Question: Which visualization type does this figure use?
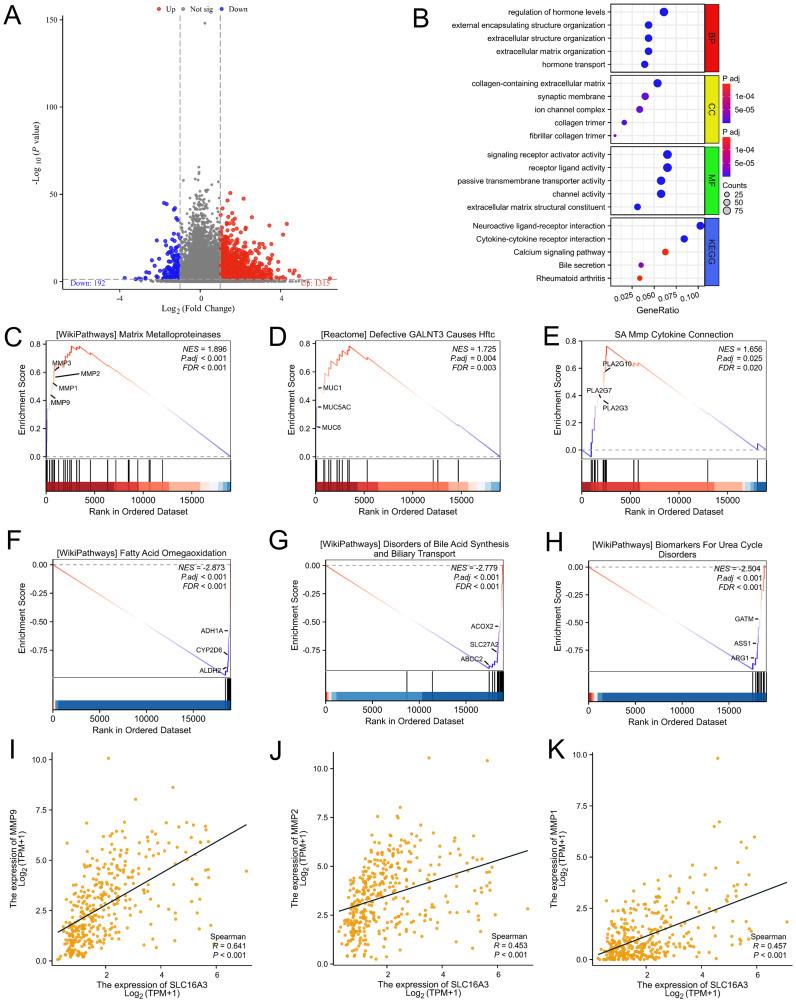
Answer: scatter